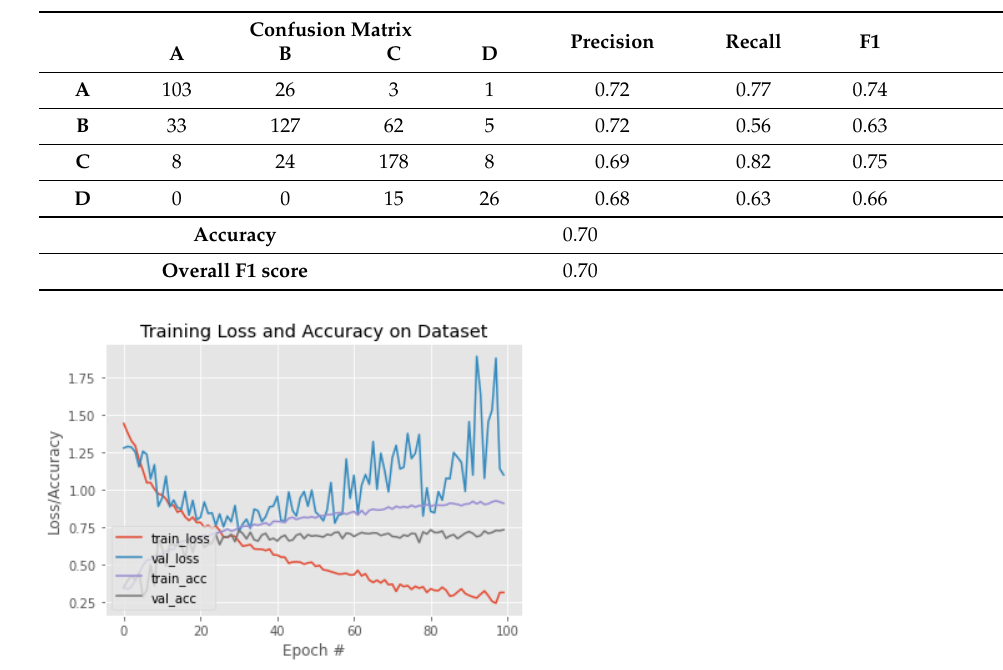
Figure 19. The training behavior of the model based on